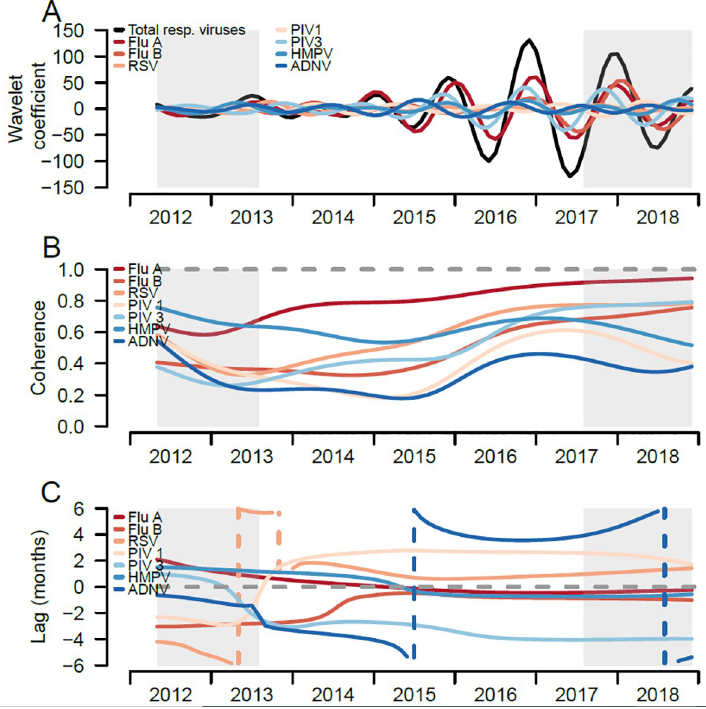
Fig 4. Trends of respiratory viral infections of pediatric participants, Sentinel Enhanced Dengue Surveillance System (SEDSS), Southern Puerto Rico, 2012–2018. A) Reconstructed seasonal patterns of monthly respiratory viral infections using the wavelet coefficient, total and individual respiratory viruses. Seasonal period was defined 8 to 16 months. B) Coherence comparing the similarity between the individual respiratory viruses patterns and the total respiratory infections. Dashed line at 1 refers to identical seasonal patterns and coherence at 0 refers to no association of two seasonal time-series. C) Phase differences comparing the timing of individual to total respiratory infections. Dashed line at 0 refers to patterns of individual and overall respiratory infections occurring at the time (i.e. no difference in phase). Grey shading reflects the cone of influence, where edge-effects of the time-series become